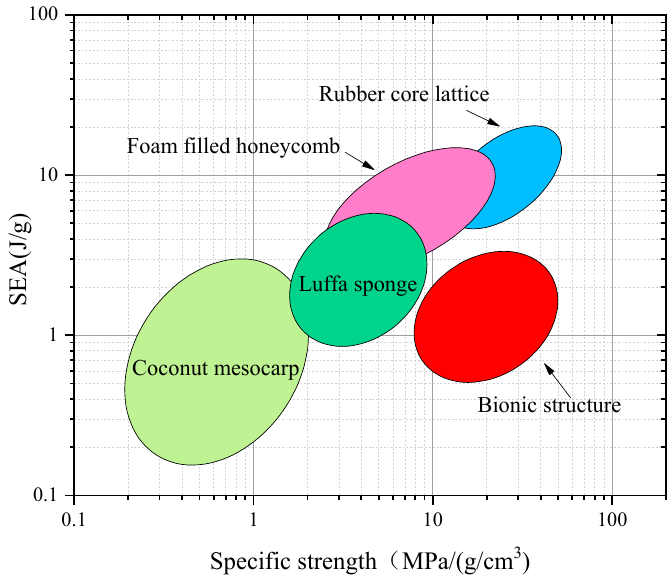
Figure 16. Comparison of SEA and specific strength among bionic structures and the other materials [11,28].